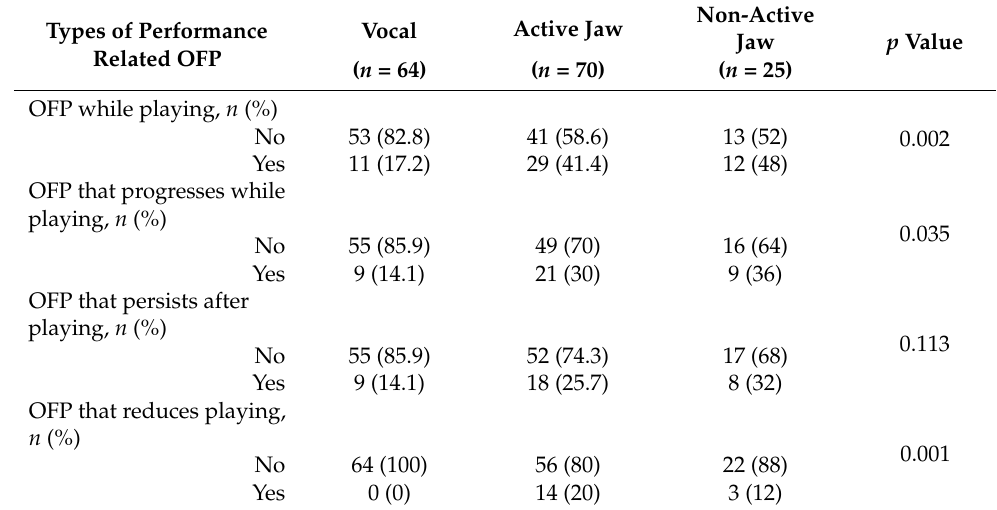
Table 5. Prevalence of different performance-related orofacial pains (OFP) among